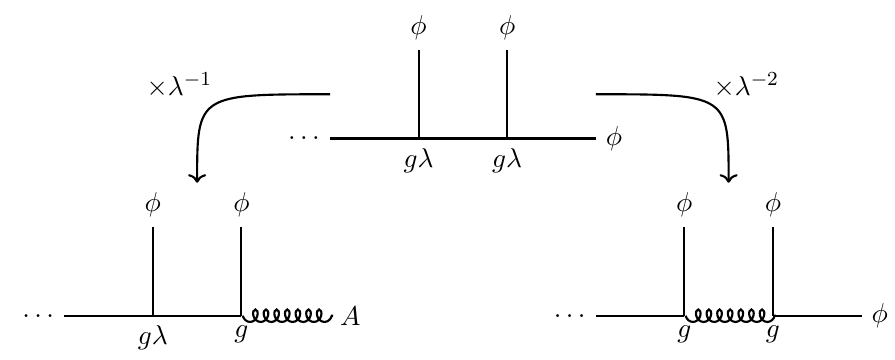
Figure 2 . Trading an external scalar for a gluon effectively removes a power of λ (left panel). Similarly, increasing the number of traces effectively removes two powers of λ (right